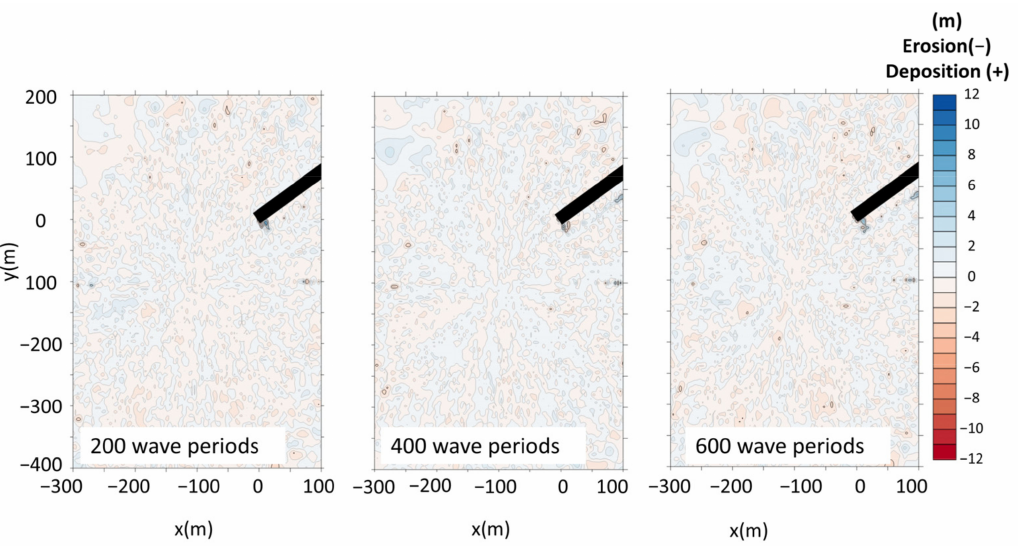
Figure 23. Topographic change under the action of monsoon